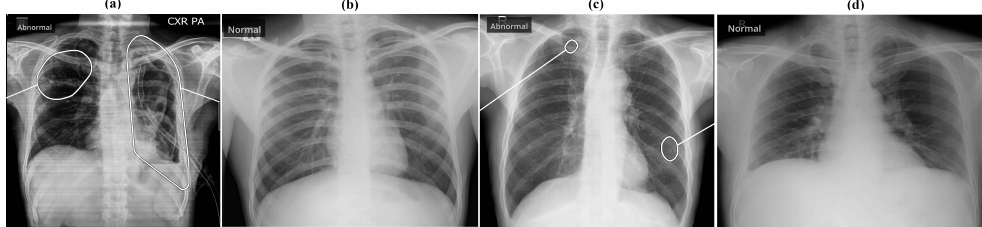
Figure 6. The CXR classified by qXR as ( a ) true positive (TP), ( b ) true negative (TN), ( c ) false positive (FP), and ( d ) false negative (FN). ( a ) Predicted as abnormal with impression of cavity, pleural effusion, pneumothorax, opacity, consolidation and fibrosis in the left lung while cavity and opacity were also predicted in the right lung. ( b ) Predicted as normal. ( c ) Predicted as abnormal with pleural effusion, pneumothorax and opacity in the left lung and right lung. ( d ) Predicted as